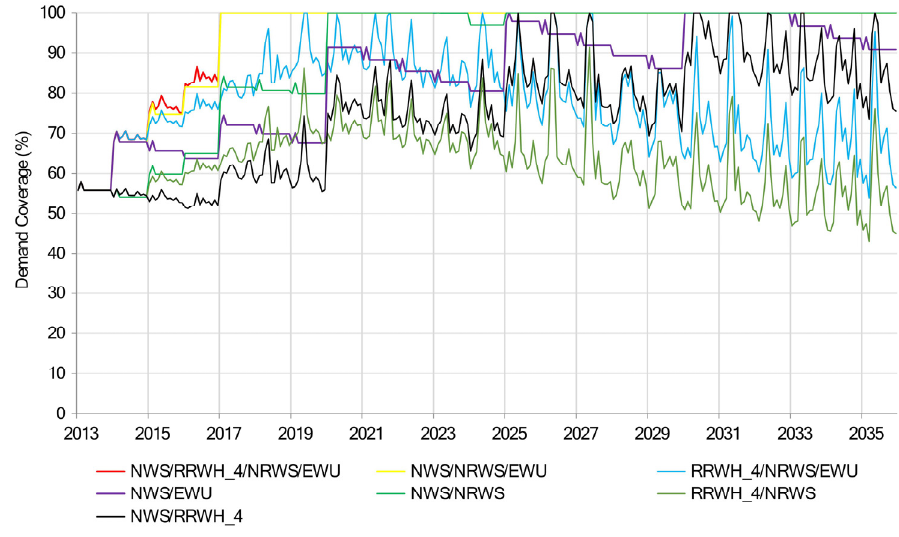
Figure 11. Demand coverage under different scenario combinations for Mombasa City.